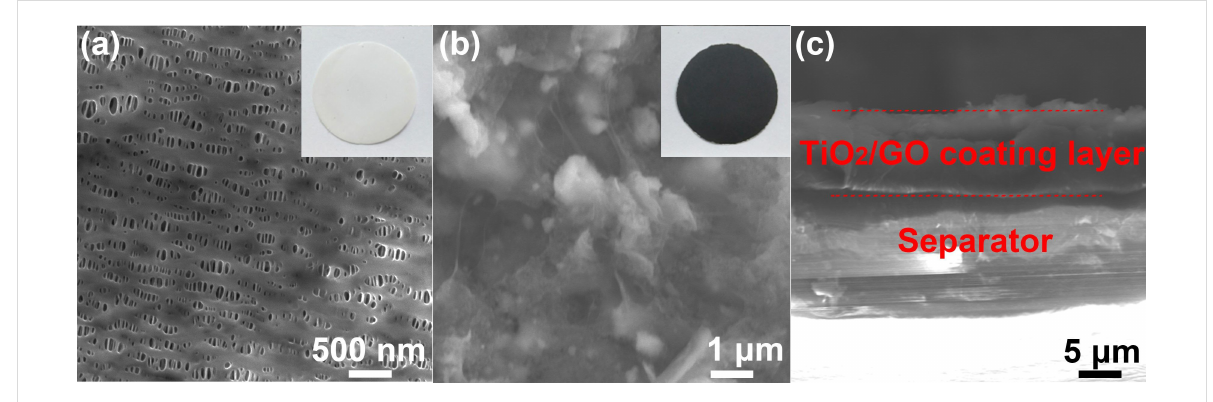
Figure 4: Surface SEM images of (a) a pristine separator, (b) a TiO 2 /GO-coated separator and (c) the TiO 2 /GO-coated separator as a cross-sectional view. Insets in panel (a) and (b) are the digital photographs of the pristine and the TiO 2 /GO-coated separator, respectively.